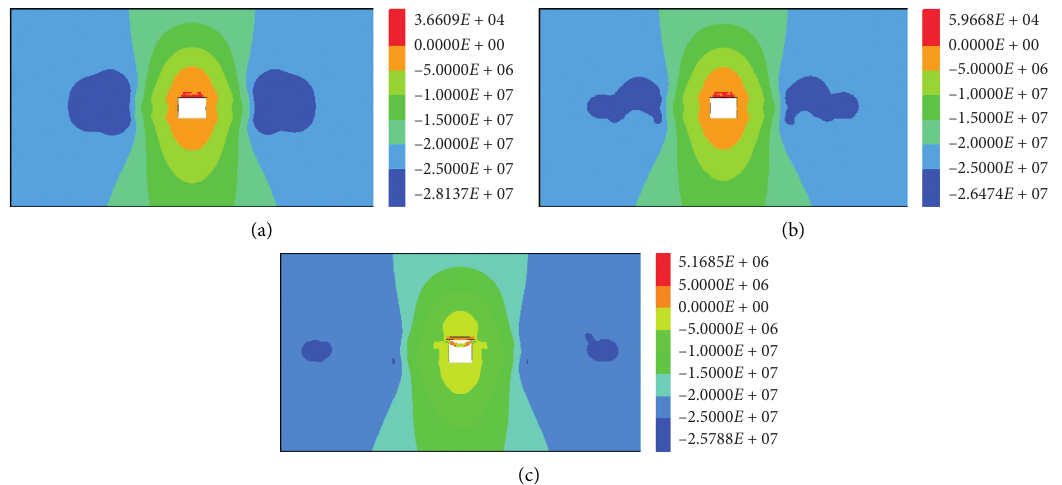
Figure 6: Vertical stress of roof of different horizontal stresses: (a) 20MPa, (b) 30MPa, and (c) 40MPa.